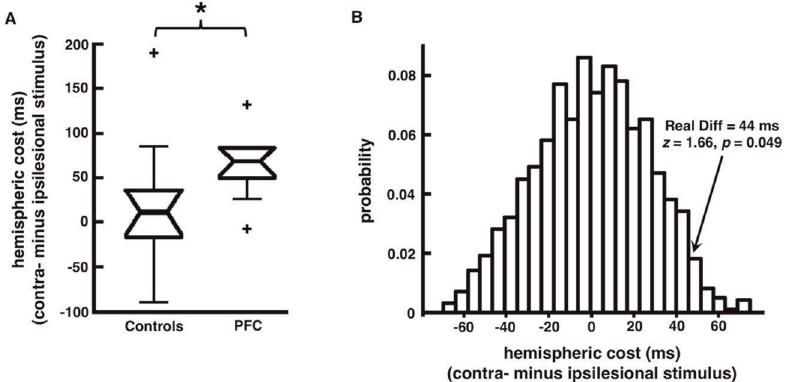
Figure 5. Effects of Early Mask on Patient Performance. ( A ) Box plot comparing control (left) and patient (right) hemispheric cost during the mask condition (contralesional minus ipsilesional). Nine out of the ten participants show this hemispheric cost whereas control subjects show no real bias. ( B ) We confirmed group differences by way of resampling statistics (see Methods ), which confirm that the hemispheric behavioral asymmetry is greater in patients compared to controls (z=1.66, p=0.049). (*), significant difference with p=0.050.